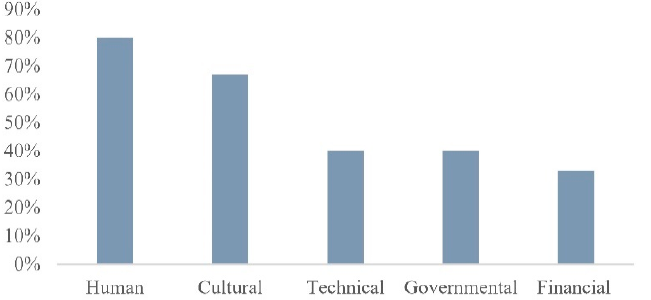
Figure 4. Key factors affecting the Industry 4.0 implementation in Kazakhstan